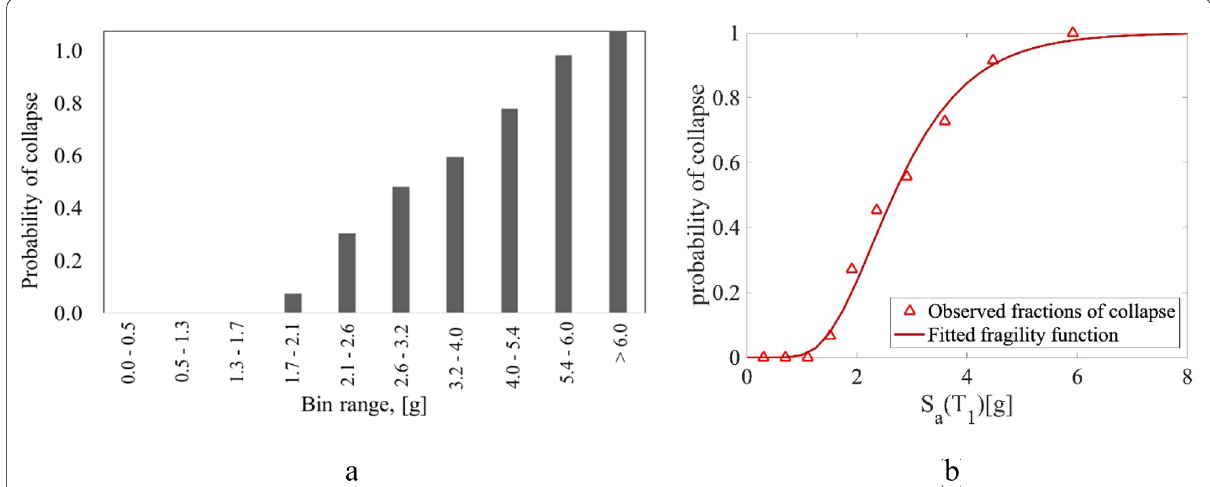
Fig. 13 Fragility function development. a Collapse rates in each bin for model FS02. b Log-normal fitted function to observed collapse fractions.